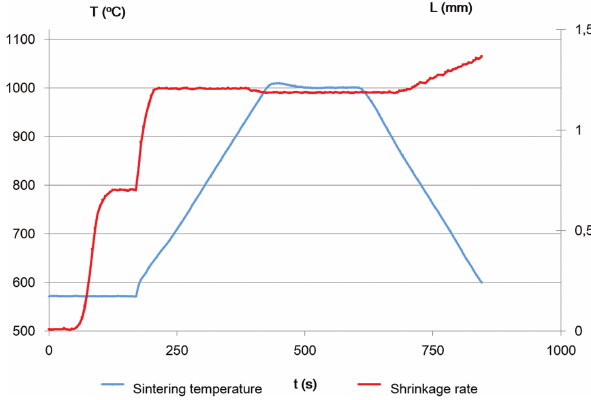
Figure 7: Typical sintering graph for hydroxyapatite (nanohydroxya- patite, temperature of isothermal holding is